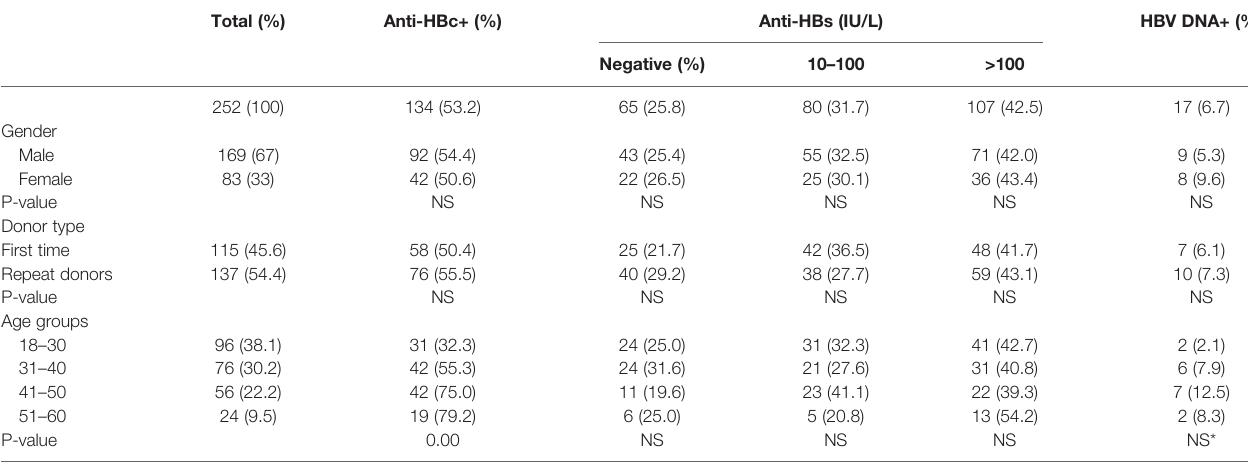
TABLE 1 | Demographic and viral characteristics of 252 (42 pools) non-resolved blood donations.